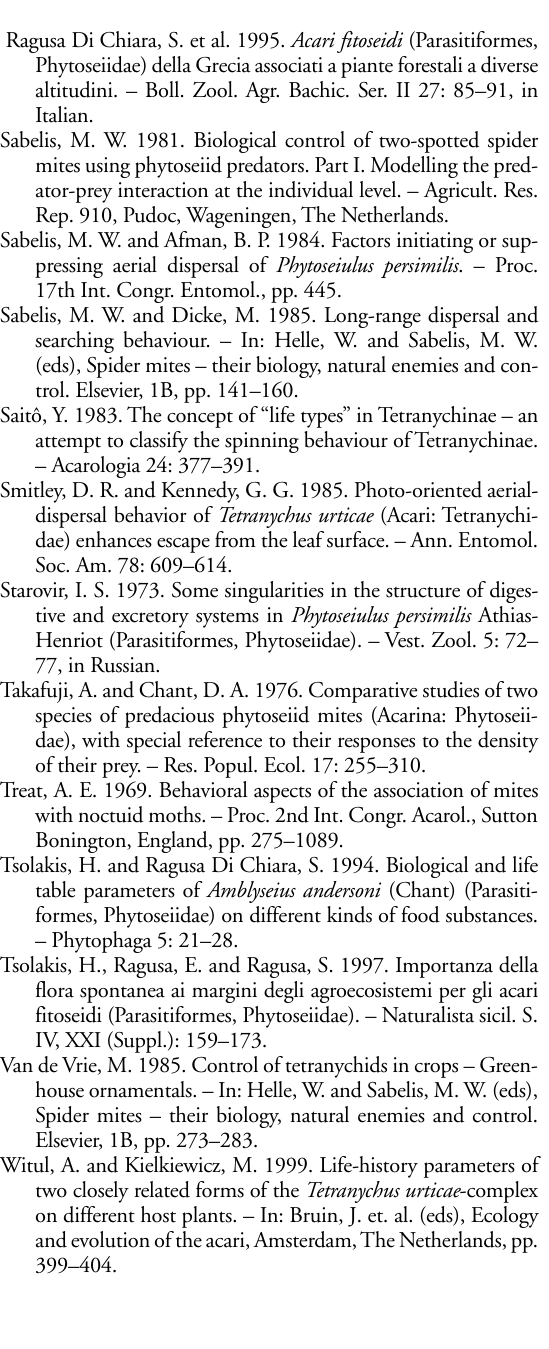
table parameters of Amblyseius andersoni (Chant) (Parasiti- formes, Phytoseiidae) on different kinds of food substances. – Phytophaga 5: